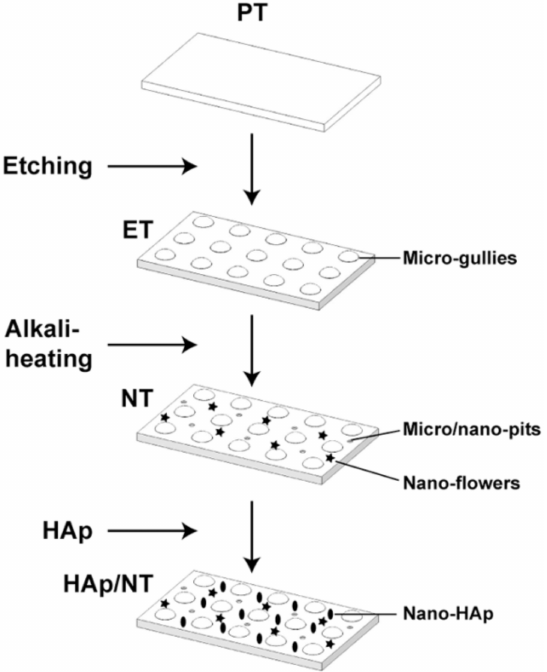
Figure 11. Surface topographical changes during the pre-treatment of the titanium foil surface before and after the addition of hydroxyapatite (HA). (Reproduced with permission from Liu et al., Rapamycin / sodium hyaluronate binding on nano-hydroxyapatite coated titanium surface improves MC3T3-E1 osteogenesis; published by PLOS ONE, 2017, CC BY 4.0